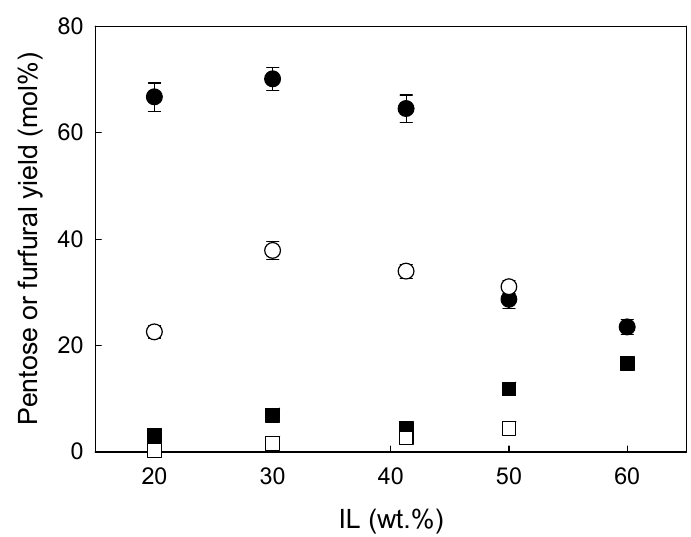
Figure 1. The yields of ( ● ○ ) pentose (sum of arabinose and xylose) or ( ■ □ ) furfural as a function of ionic liquid (IL) concentration (wt.%) obtained from pre-treatment of wheat straw (filled symbols) and eucalyptus residues (open symbols) performed at 140 °C for 90 min.